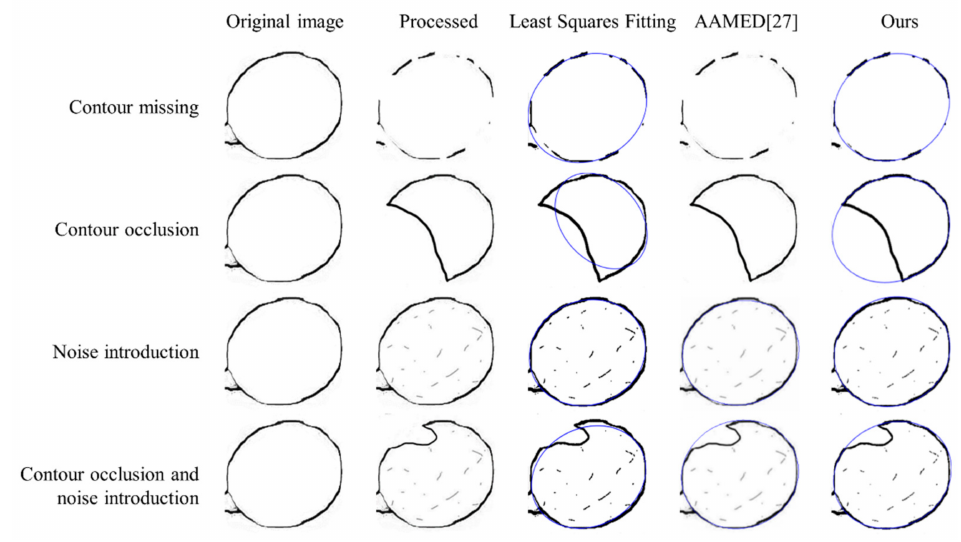
Figure 13. Grape contour-fitting results. Table 5. Measurement results of long axis of different grape particle contours by different